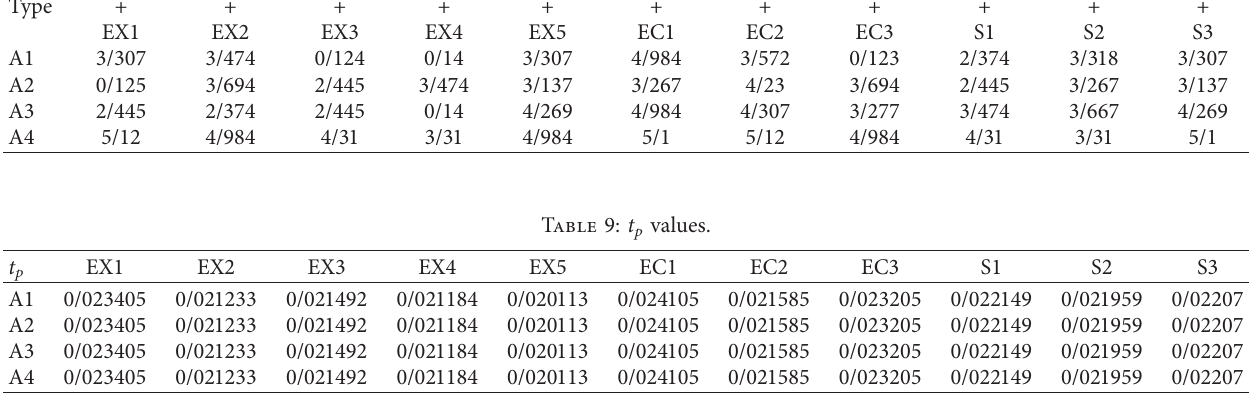
Table 10: Values of t